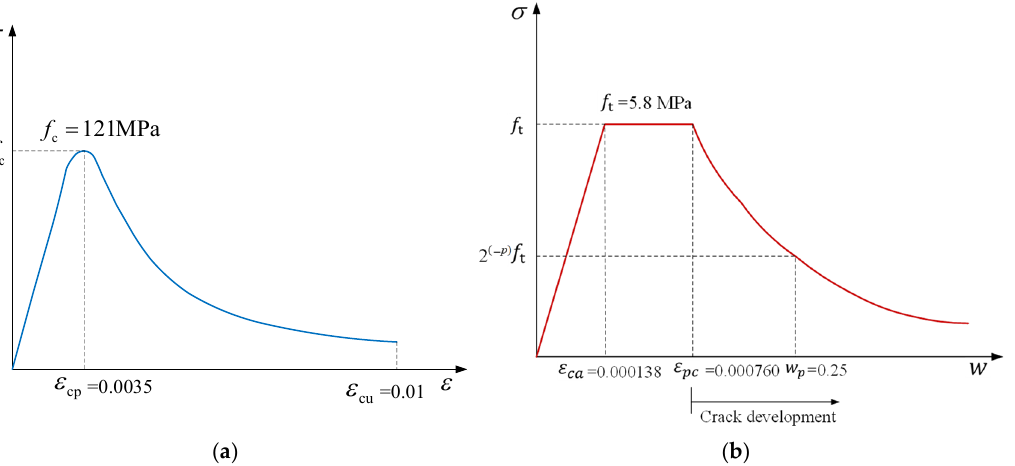
Figure 8. Constitutive relationship of the UHPC: ( a ) compression; ( b ) tension.